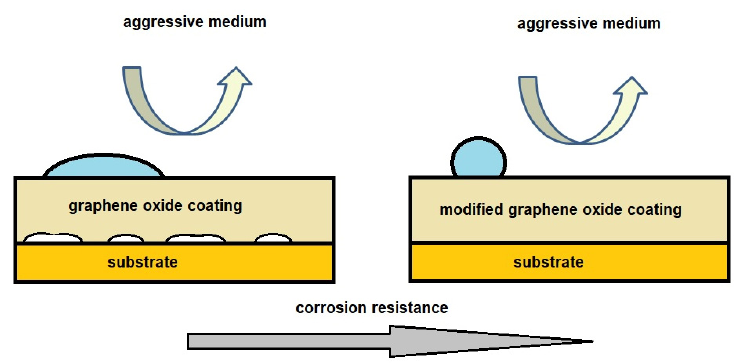
Figure 2. Mechanism protection of graphene coatings.